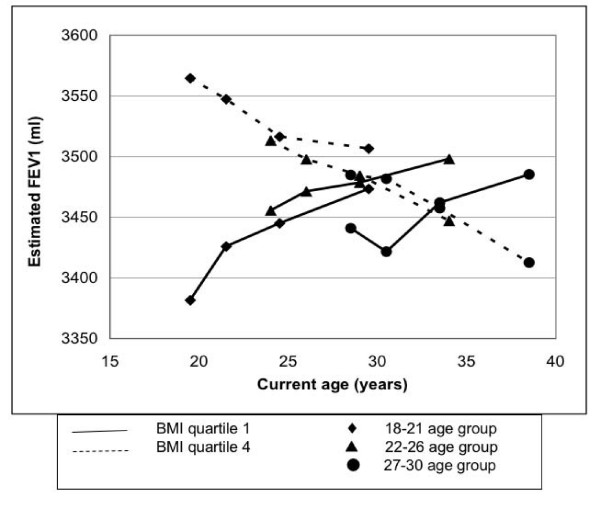
FEV1 in year 0 BMI quartiles across three birth cohorts: 18–21 years, 22–26 years, and 27–30 years at baseline, based on repeated measures linear regression analysis and adjusted for race, sex, current age, smoking status at year 0, asthma status, time, physical activity score at year 0, and alcohol consumption at year 0. The slope of FEV1 across time becomes increasingly negative with increasing year 0 BMI (p trend < 0.0001).